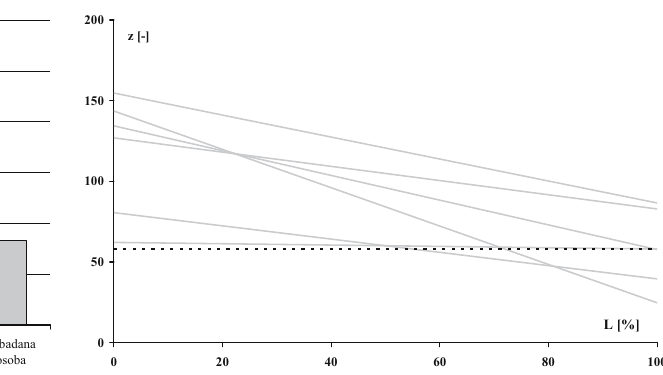
Figure 9: Comparison of the dependence of the braking e ffi ciency index on the relative position of the driver ’ s seat for individual examined persons for the Peugeot Partner car.